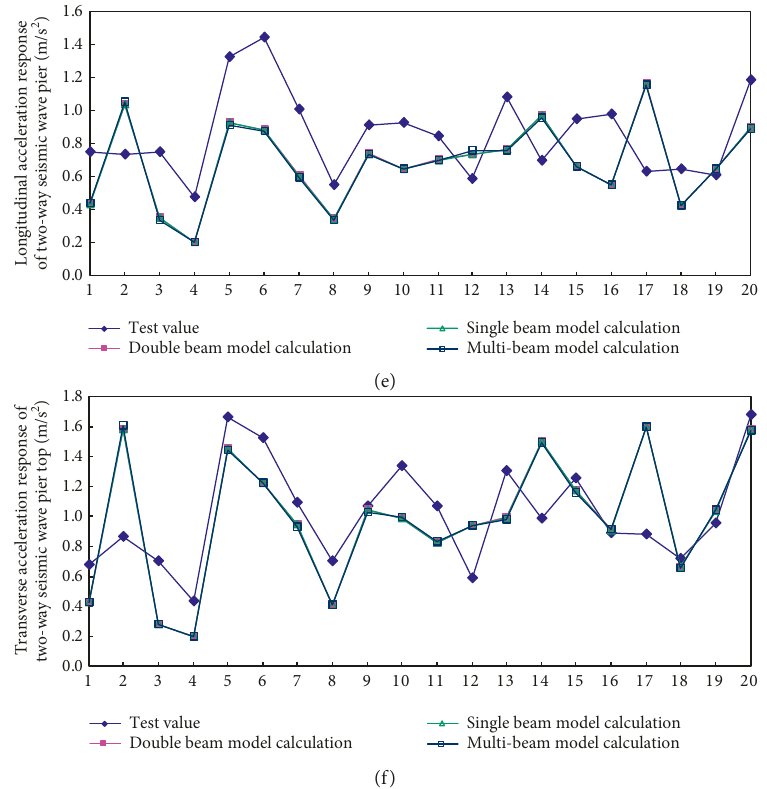
Figure 5: Acceleration response under the action of two-way seismic waves. (a) Bridge deck left end portrait. (b) Bridge deck left end lateral. (c) Bridge right side portrait. (d) Bridge right side horizontal. (e) Pier top portrait. (f) Pier top